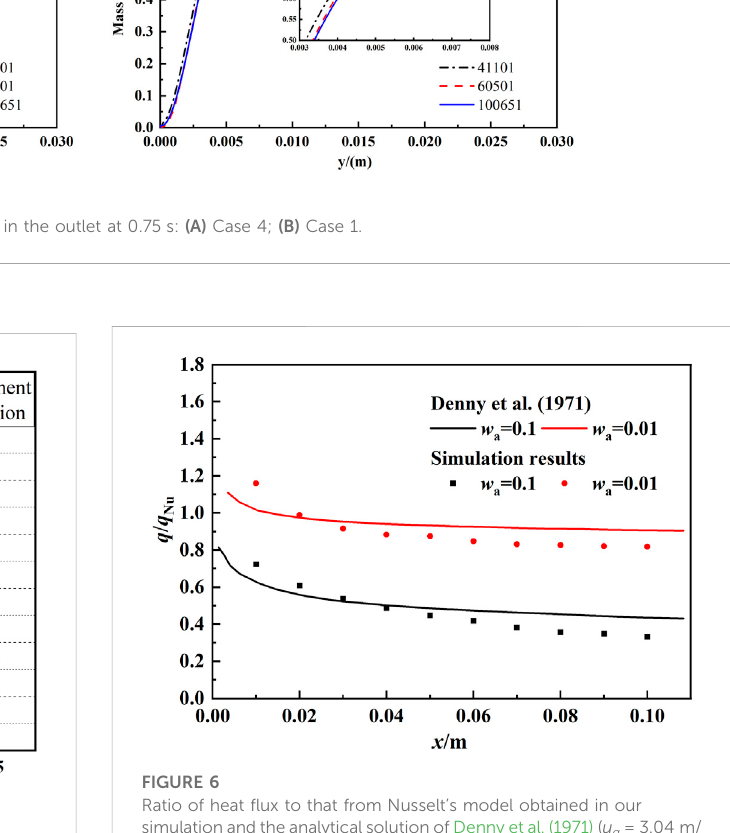
FIGURE 5 Comparison of the average heat transfer coef fi cients obtained in our simulation and Yi ’ s experiment ( u g = 1 m/s).